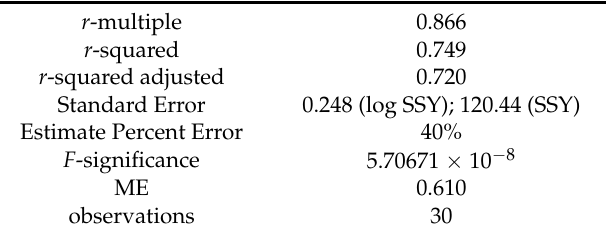
Table 2. ANOVA of regression model